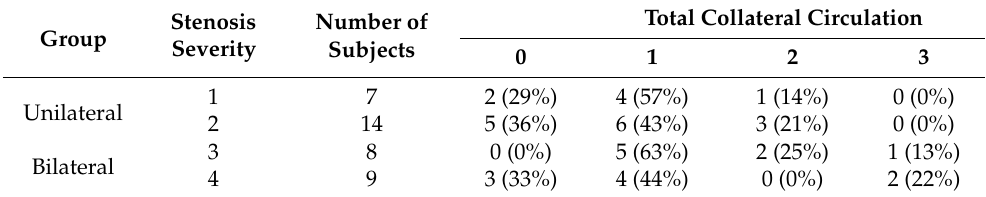
Table 3. Presence of collateral circulation for each stenosis severity. For the patients that had imaging scans, the table shows the number of patients (proportion) with collateral circulation, separated by the total number of communicating arteries with collateral